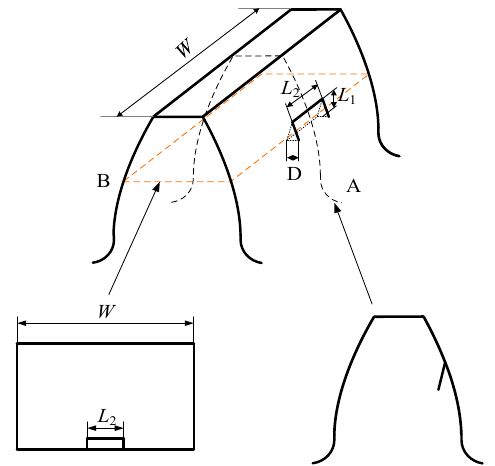
Figure 1. Geometric parameters of tooth surface crack.